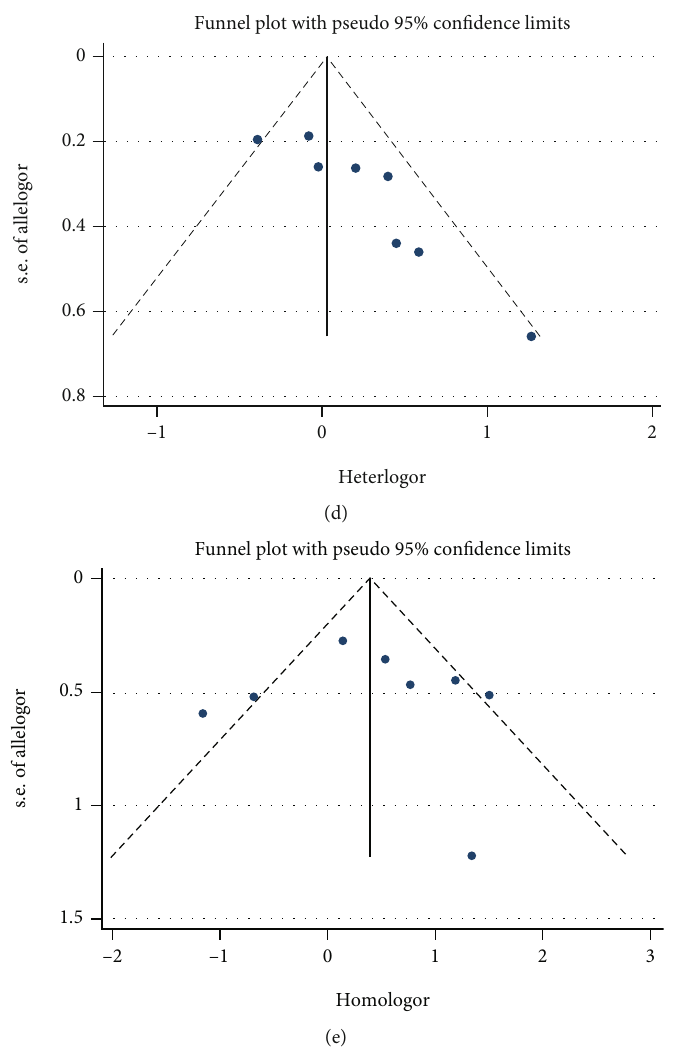
Figure 3: Funnel plot of fi ve gene models for the association between MTHFR C677T polymorphisms and mild cognitive impairment. (a) Allelic model (T vs. C), (b) dominant model (CT+TT vs. CC), (c) recessive model (TT vs. CC+CT), (d) heterozygous model (CT vs. CC), and (e) homozygous model (TT vs.